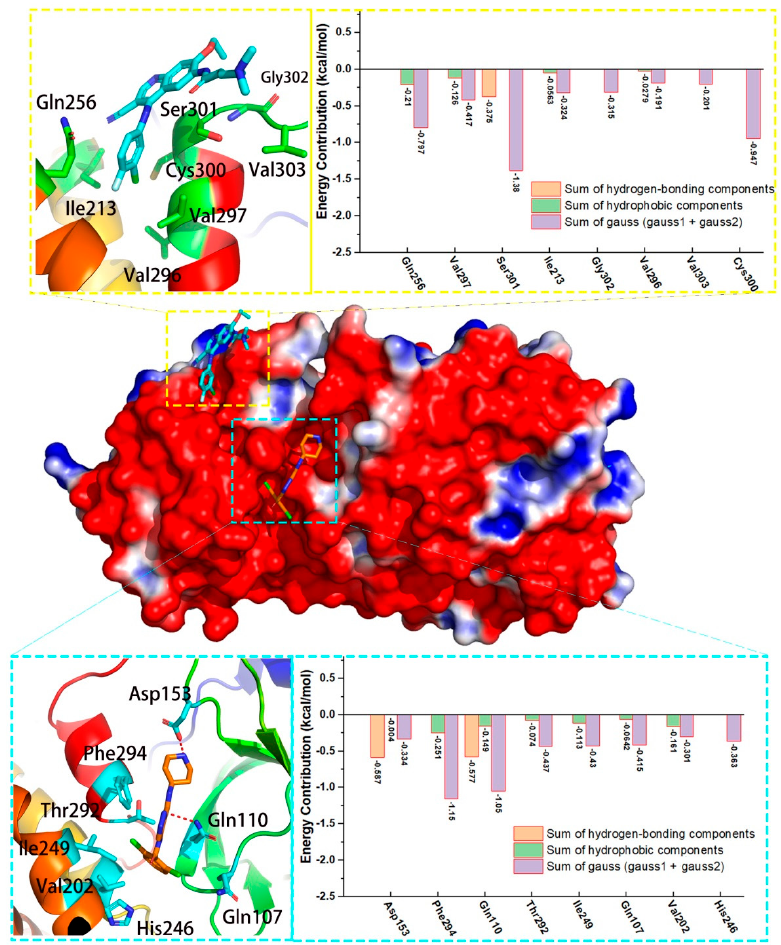
Figure 5. Two representative allosteric modulators in different allosteric sites of M pro . The detailed interactions and energy contribution of two allosteric modulators in M pro . Bound compounds are depicted sticks and the surface of M pro is colored by potential on solvent accessible